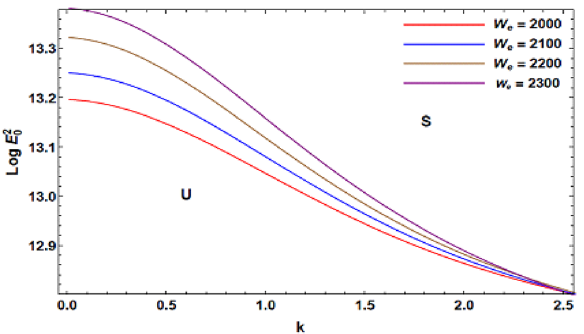
Figure 2. linear stability shape corresponding to Eq. (51) for the deviation of We